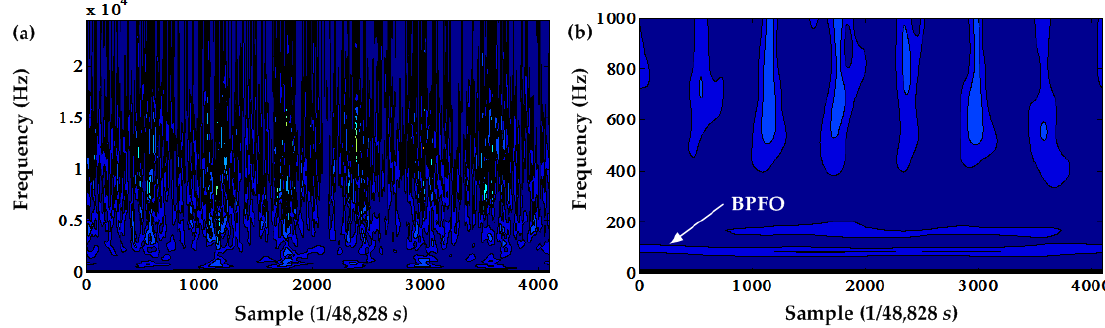
Figure 5. ( a ) Time-frequency contour of the envelope signal of the original bearing fault signal; ( b ) local amplification of ( a ) between 0 and 1000 Hz. BPFO, ball pass frequency outer race.